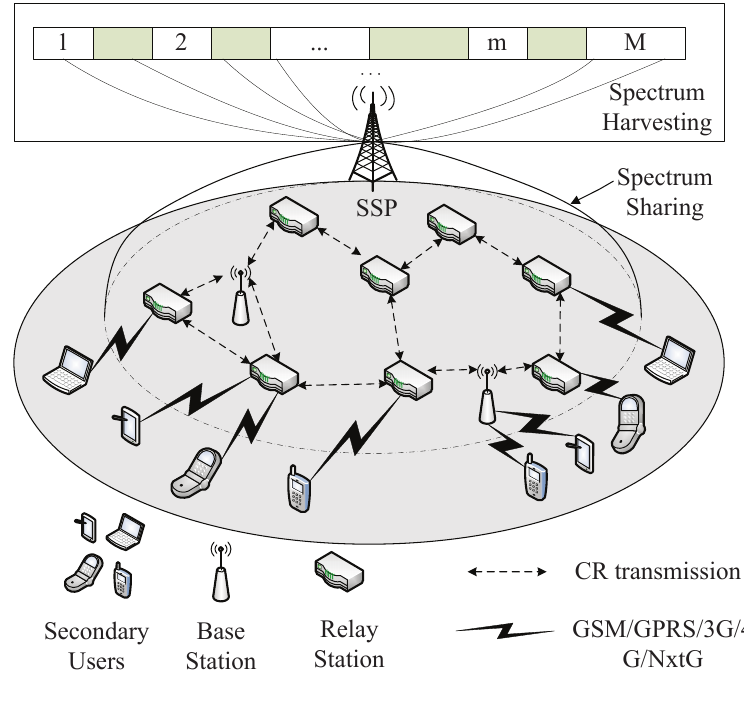
Figure 1. System architecture of